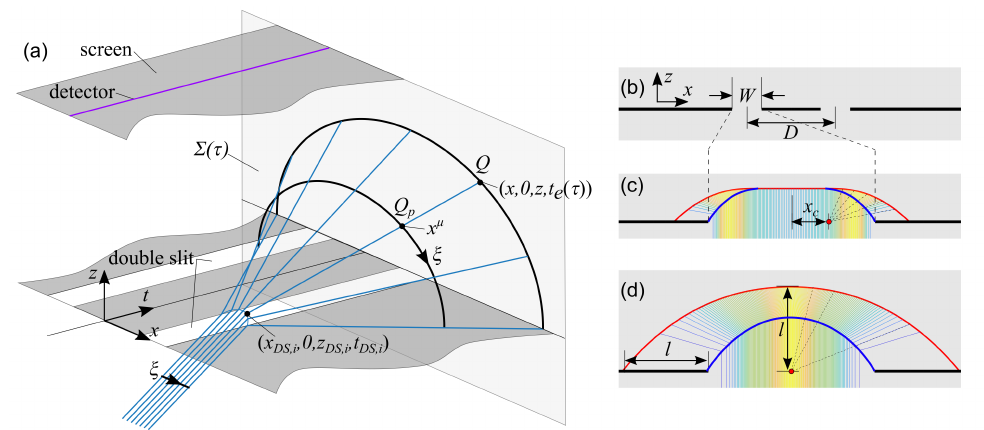
Figure 3. ( a ) Illustration of a selection of particle worldlines (blue lines) before and after the double slit. The hypersurface Σ ( τ ) is shown containing the worldline endpoints. The quantum measure Q is indicated at the endpoint ( x ,0, z , t e ( τ )) of a particular worldline and Q p ( x µ ) , which takes the same scalar value as Q ( x ,0, z , t e ( τ )) , is indicated at the event x µ along the same worldline. Additionally, the deflection event ( x DS , i ,0, z DS , i , t DS , i ) at the disclination line is marked. Two examples of curves orthogonal to the particle worldlines are shown, labeled with coordinate ξ . Furthermore, a screen and a detector worldline (purple) are indicated. ( b ) Schematic of the double-slit geometry in the ( x , z ) plane, showing the width W and separation D of the slits. The configuration of worldlines of the particle network at the left slit is illustrated in ( c ) for 0 < l ≤ W / π and in ( d ) for l > W / π . The center of the radial pattern of worldlines x c (red dot) and the disclination line (blue) are